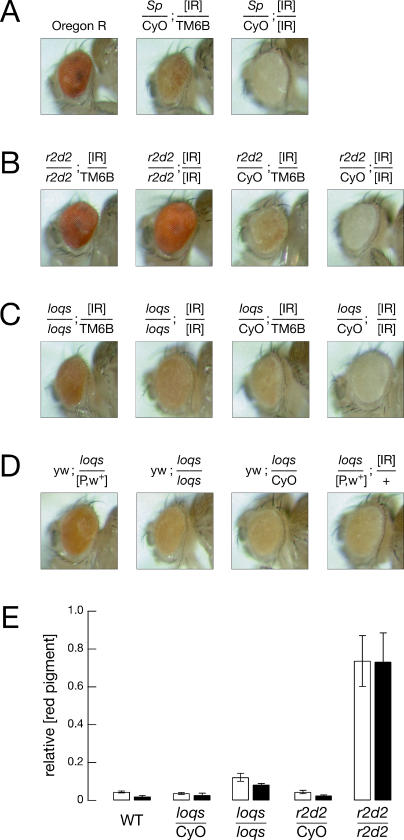
Silencing of white by an IR Partially Depends on loqs
(A) The red eye color of wild-type flies (left) changes to orange (center) and white (right) in response to one or two copies, respectively, of a white IR transgene, which silences the endogenous white gene.(B) Homozygous mutant r2d2 flies fail to silence white, even in the presence of two copies of the white-IR transgene; heterozygous r2d2/CyO flies repress white expression.(C) In flies homozygous for loqs
f00791, silencing of white by the white-IR is less efficient; two copies of the white-IR do not produce completely white eyes, whereas they do in heterozygous loqs
f00791/CyO.(D) The eye color change in loqs
f00791 flies is not caused by the increased white+ gene dose resulting from the mini-white marker in the piggyBac transposon that causes the loqs
f00791 mutation. Flies trans-heterozygous for loqs
f00791 and a mini-white-marked P-element have more red eye pigment than loqs
f00791 homozygous flies, but show more efficient silencing by the white-IR than loqs
f00791 homozygous animals.(E) The eye pigment of the indicated genotypes was extracted and quantified by green light (480 nm) absorbance, relative to wild-type flies bearing no white-IR transgenes. The graph shows the mean and standard deviation of five independent measurements per genotype.